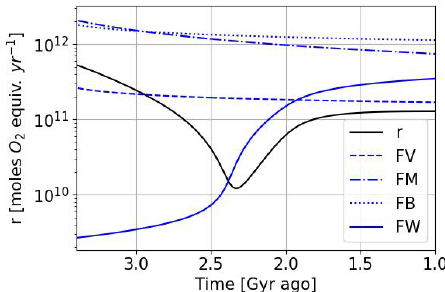
Figure 14. Temporal evolution of the reductant contributions (see Table 2) with α i = 1 and using the Goldblatt et al. (2006) parame- terization for oxygen atmospheric loss ( F O 2